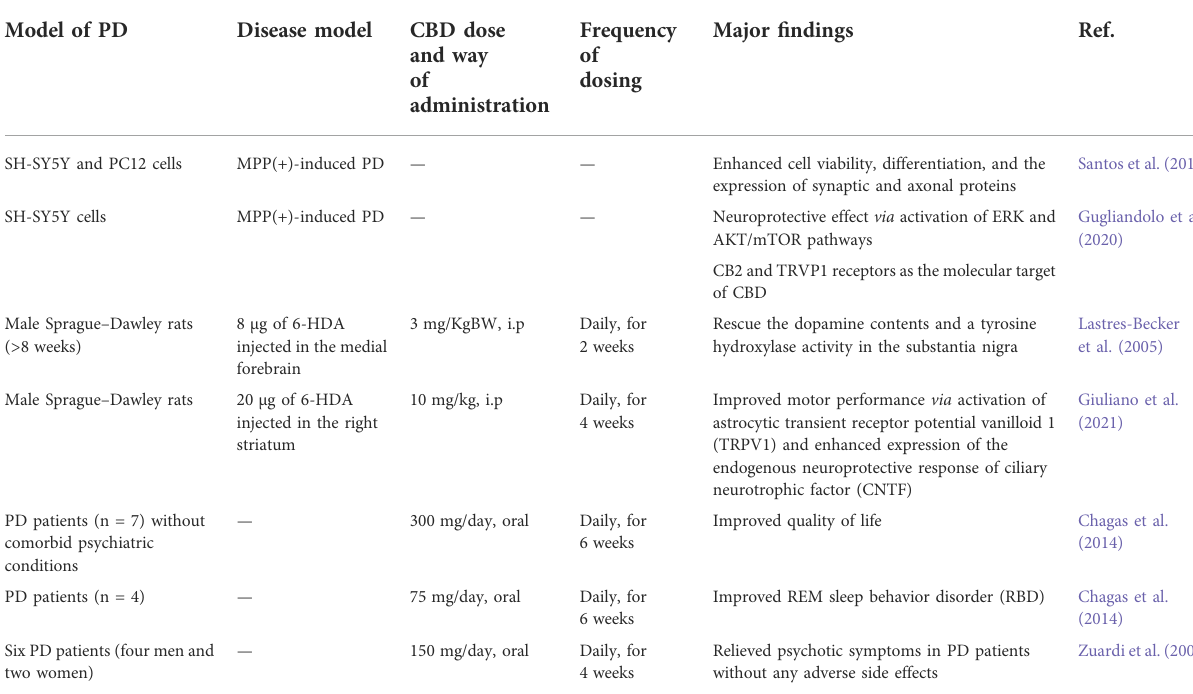
TABLE 1 CBD on PD, in vitro , in vivo , and clinical